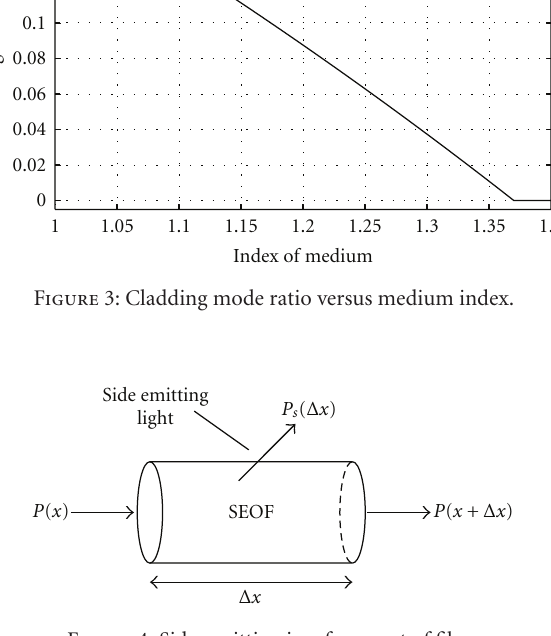
Figure 4: Side-emitting in a fragment of fiber.